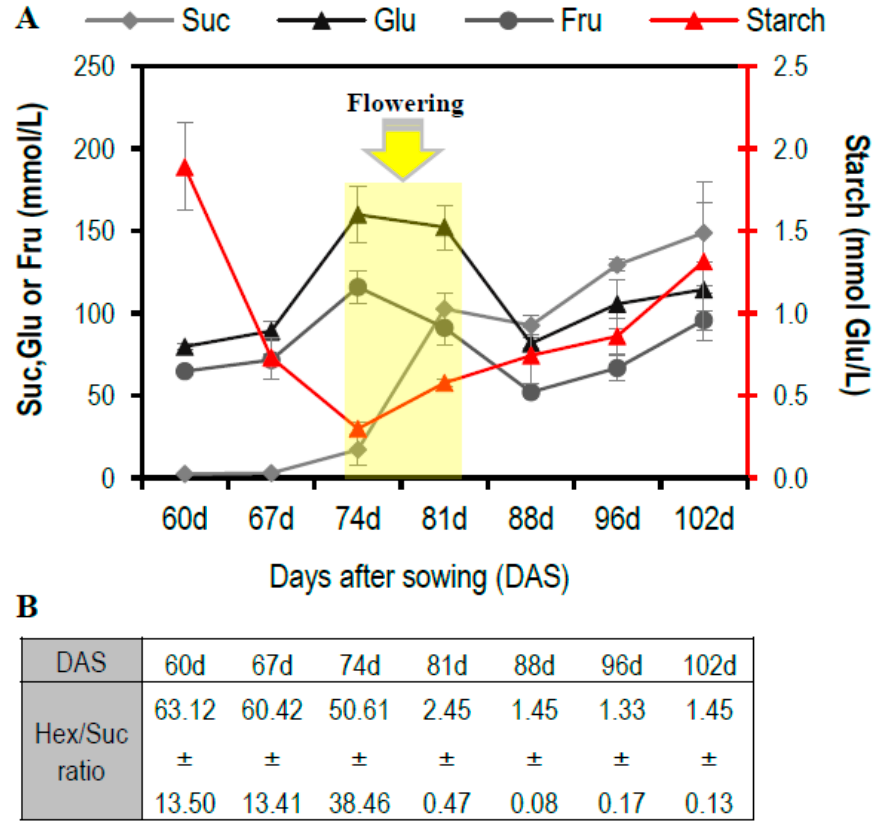
Figure 1. Carbohydrate accumulation in stem juice of the white grain Puma maize hybrid at the reproductive stage. ( A ) Non-structural carbohydrates in maize stem juice. Measurements were conducted by enzymatic assay at 340 nm. Arrow shows the stage of female and male flowering. Data points indicate means ± SE ( n = 3). ( B ) Hexose/Sucrose ratios (hexose/sucrose ratio; means ± SE, n = 3) for the stages shown in ( A ).